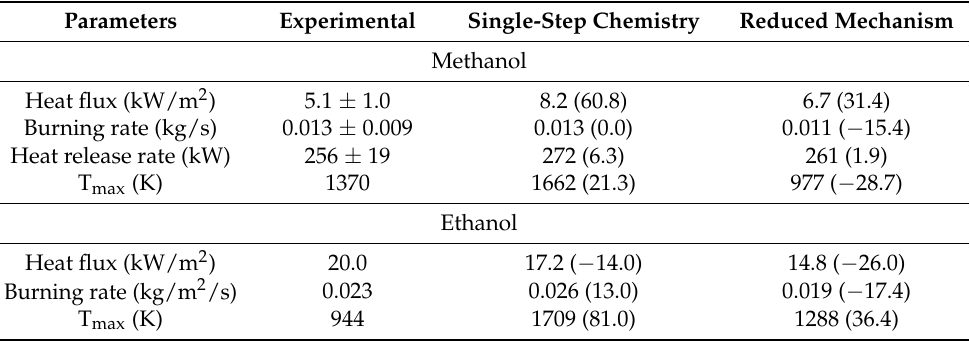
Table 5. Summary of parameters obtained from the present study for 1-m diameter methanol [35] and ethanol [36] pool fires. In brackets, the relative deviations from the experimental data are defined as 100* (estimated value − measured